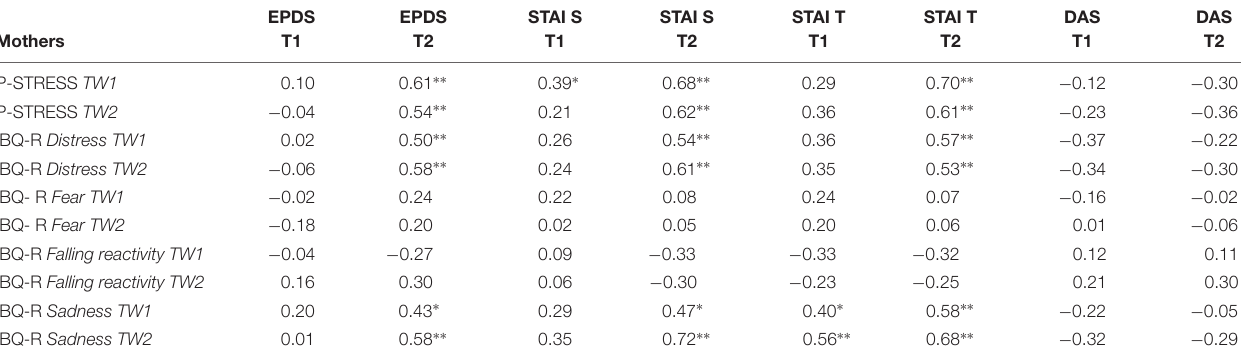
TABLE 2 | Bivariate correlations among study variables for mothers.